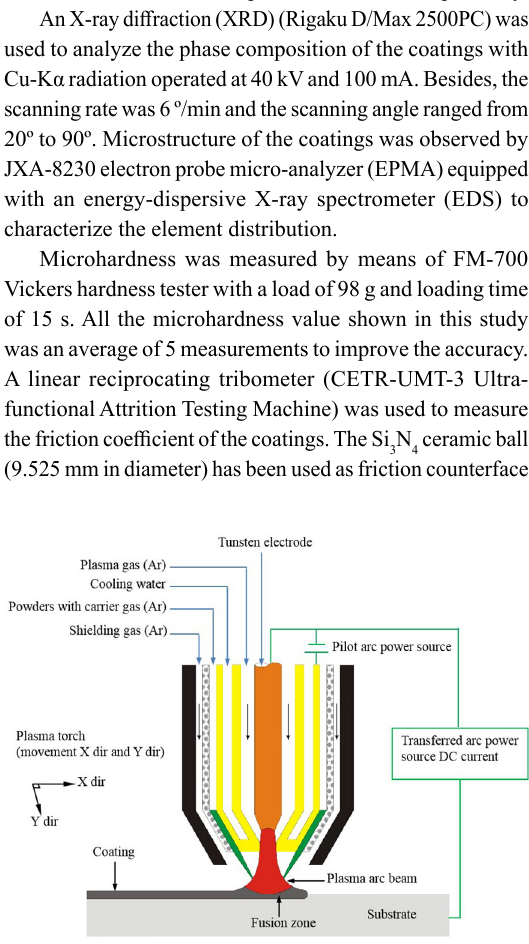
Figure 1. Schematic diagram of the PTA cladding system. Table 1. Parameters of PTA cladding.